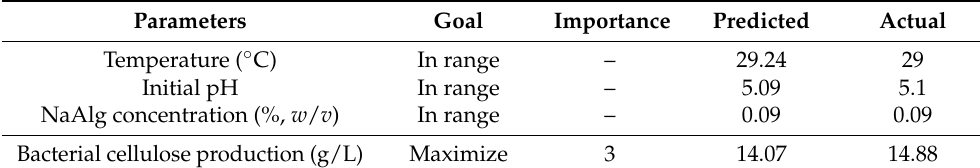
Table 4. Optimization of bacterial cellulose production using the regression model.